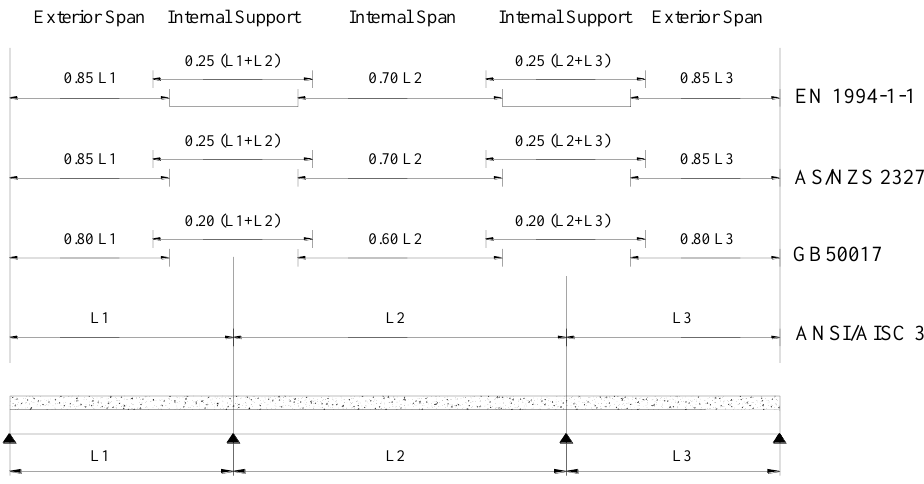
Figure 6. Equivalent span length ratios.